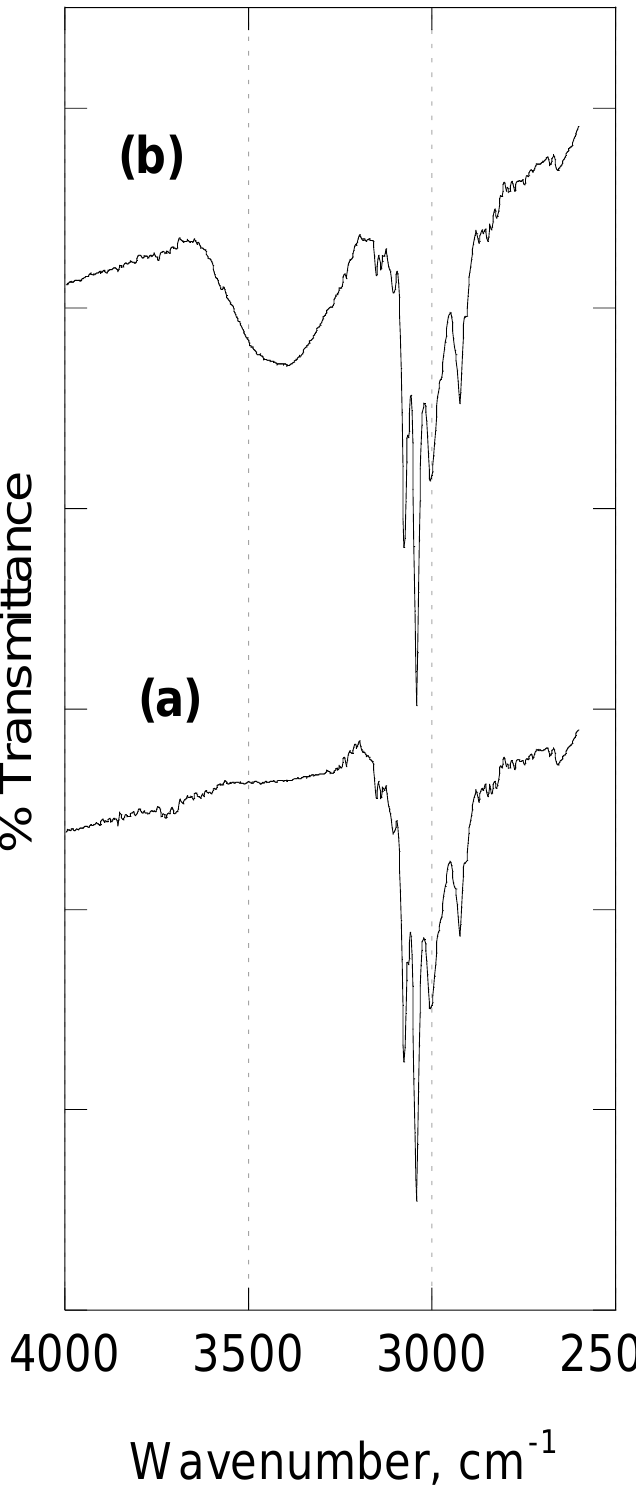
Figure 7. Magnification of FTIR spectra for ( a ) sample A and ( b ) sample B. In the thermogravimetric (TG) and the corresponding derivative (dTG) curves of Figure 8a–c, a main mass loss (and dTG peak) in the temperature range 165–325 ◦ C is observed. Three slope changes are visible and the corresponding dTG peaks are centered at around 255 and 292 with a shoulder at 305 ◦ C. This thermal behaviour can be ascribed